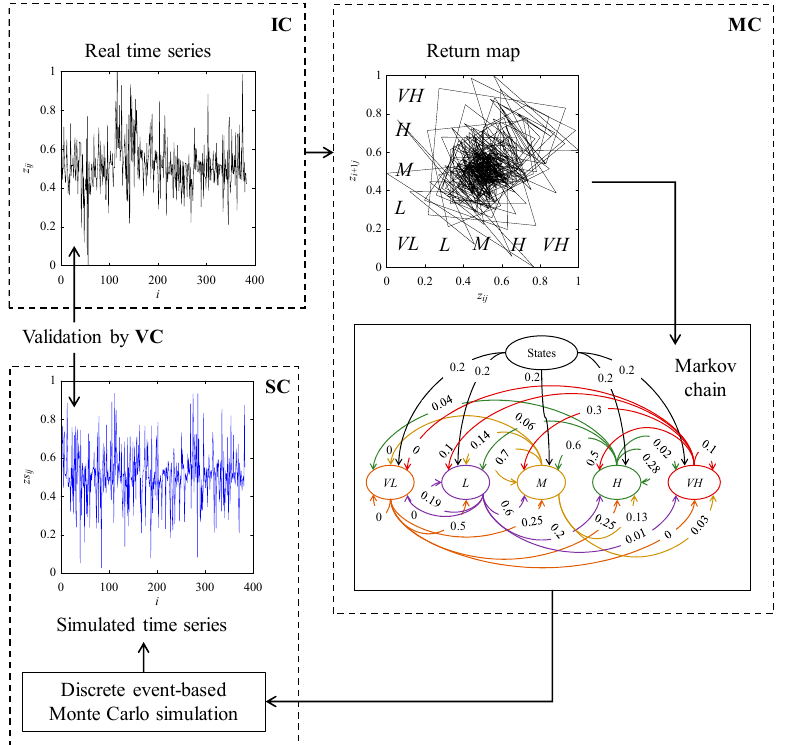
Figure 5. Outlining phenomenon twin construction of surface roughness using the Markov chain-based modeling approach [17].